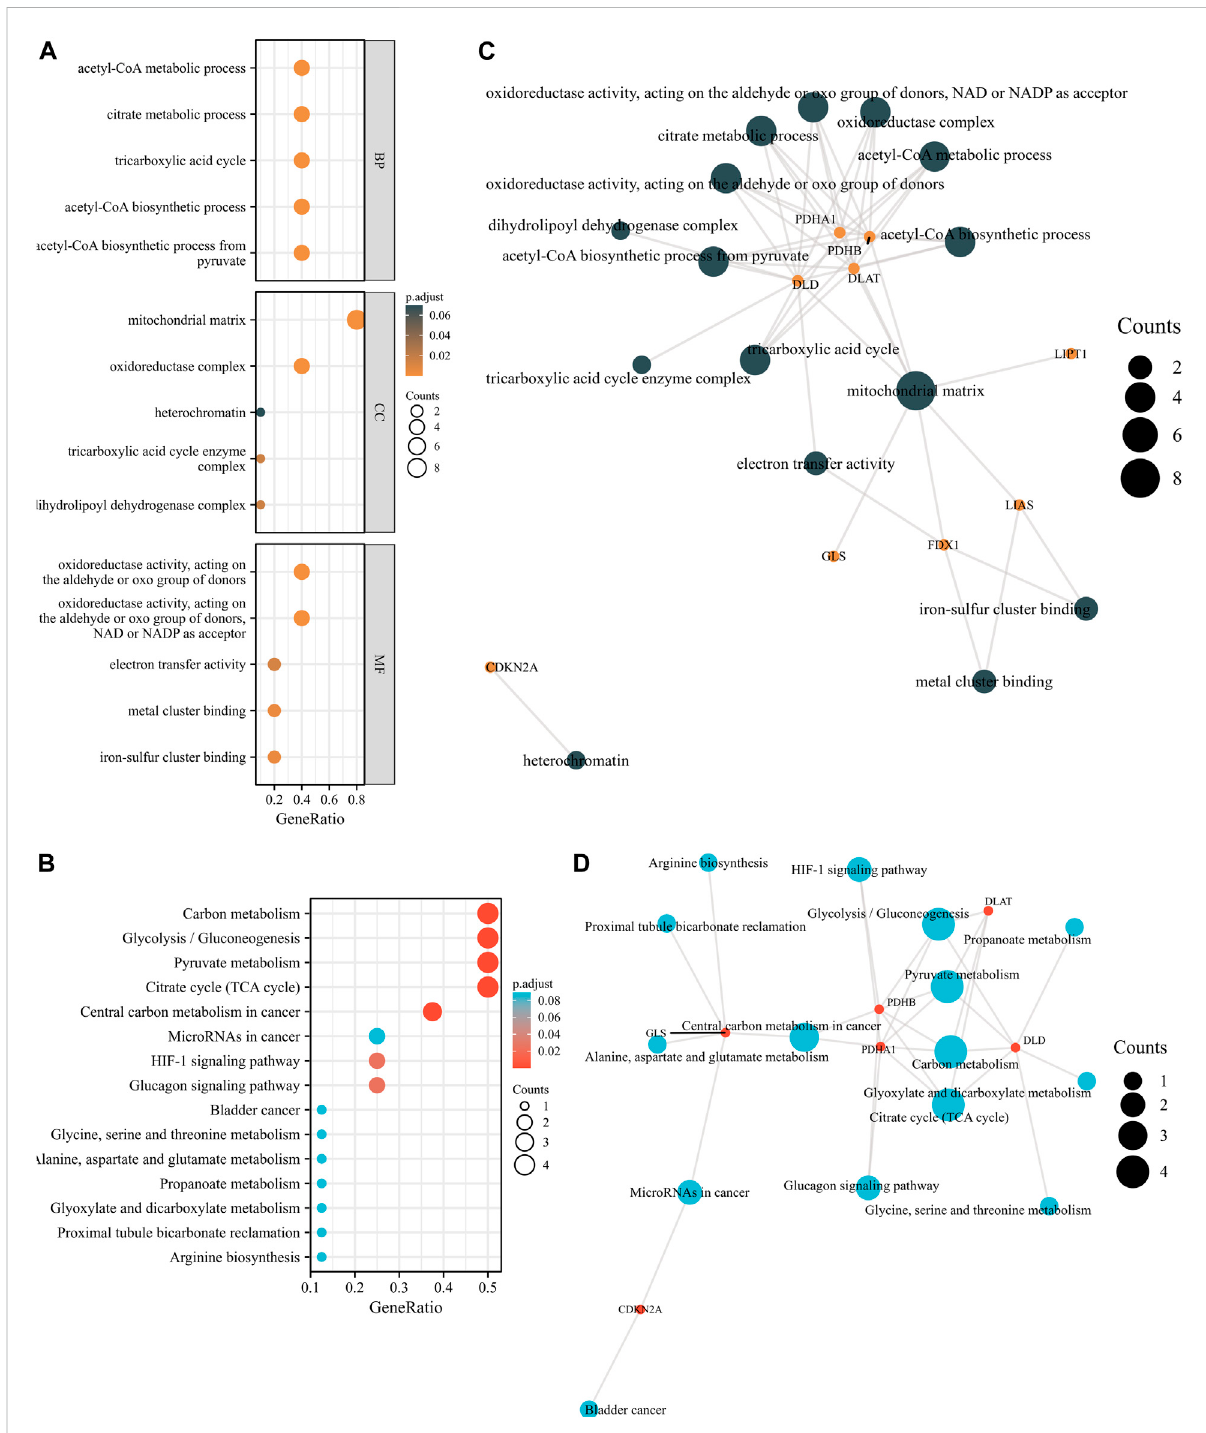
FIGURE 2 GO andKEGGenrichmentanalyses of10CRGs inLUAD. (A) Bubble plotofGO enrichmentresults of10CRGs inLUAD. (B) Bubble plotofKEGG enrichment results of 10 CRGs in LUAD. (C) Interactive network of GO entries and CRGs. (D) Interactive network of KEGG entries and